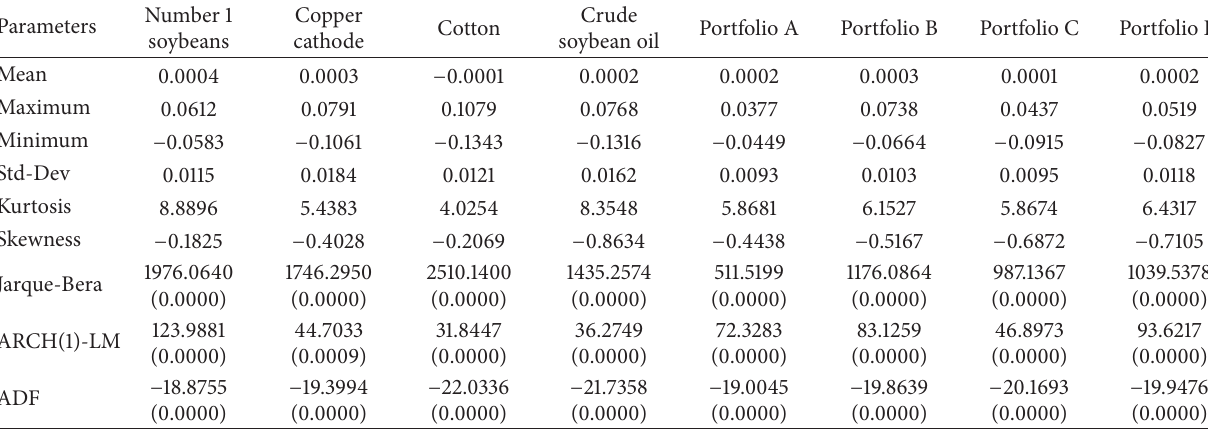
Table 2: Descriptive statistics of return series.